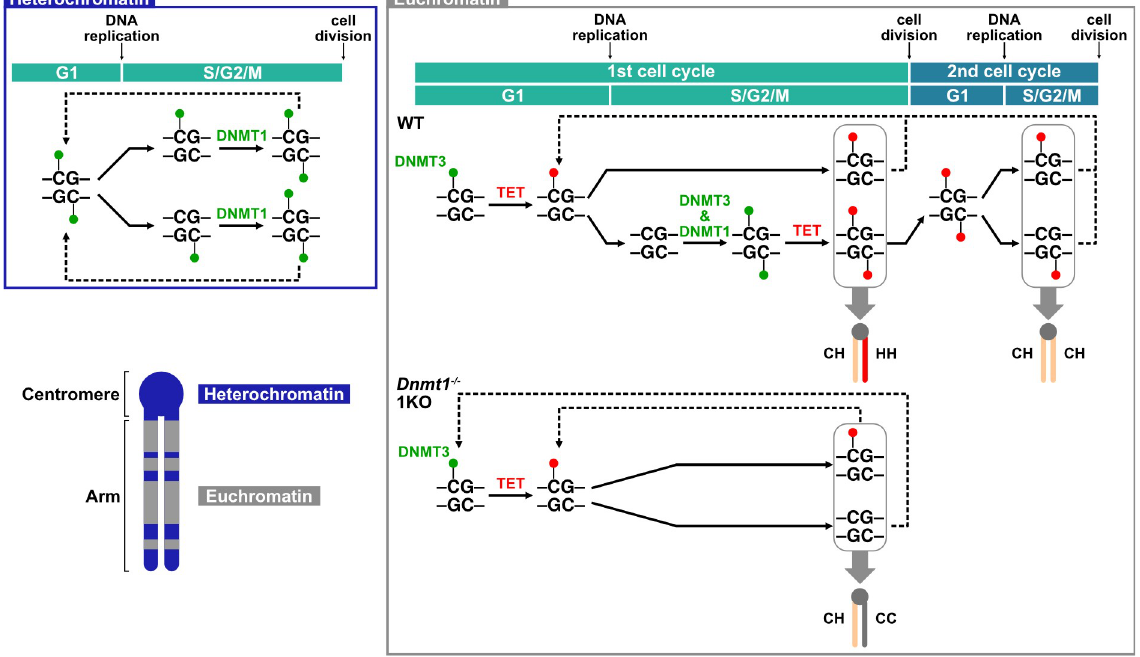
Fig 6. A model of DNA methylation regulation predicted from 5mC and 5hmC IF staining patterns in WT and 1KO ESCs. CH, hemi- hydroxymethylated double-stranded DNA (dsDNA); HH, fully hydroxymethylated dsDNA; CC, unmodified dsDNA.